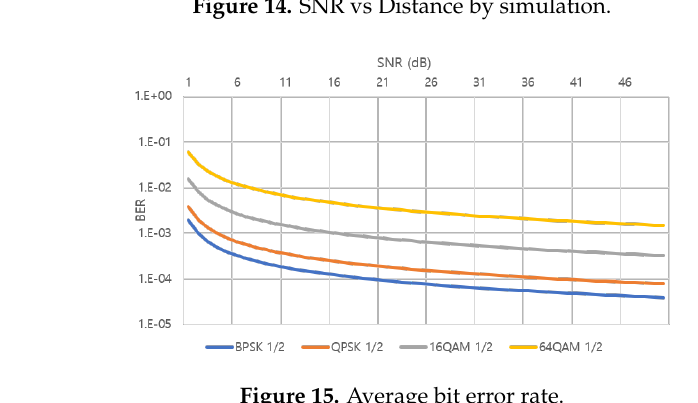
Figure 15. Average bit error rate. Table 1. Notations and